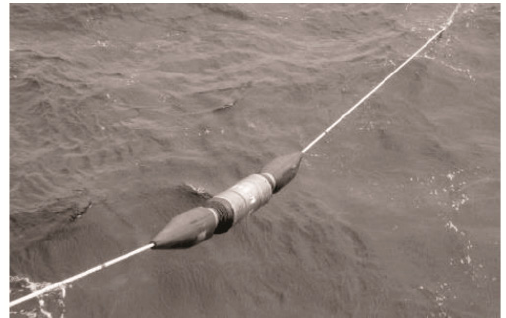
Figure 2. Laying of